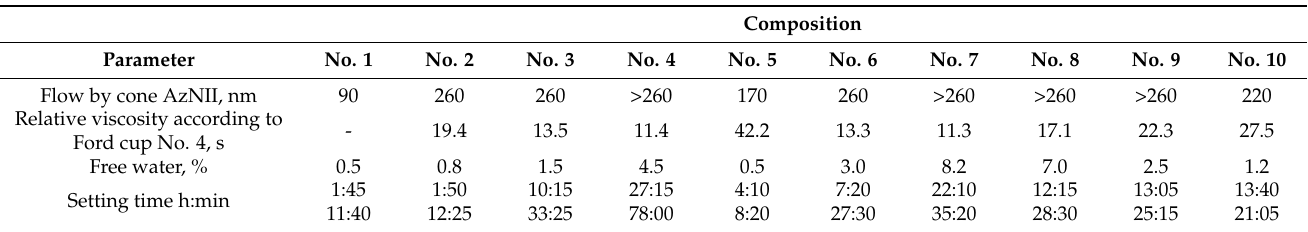
Table 2. Technological parameters of saline sealing slurries established in lab conditions at tempera- ture 20 ( ± 2 ◦ C) [293 K].